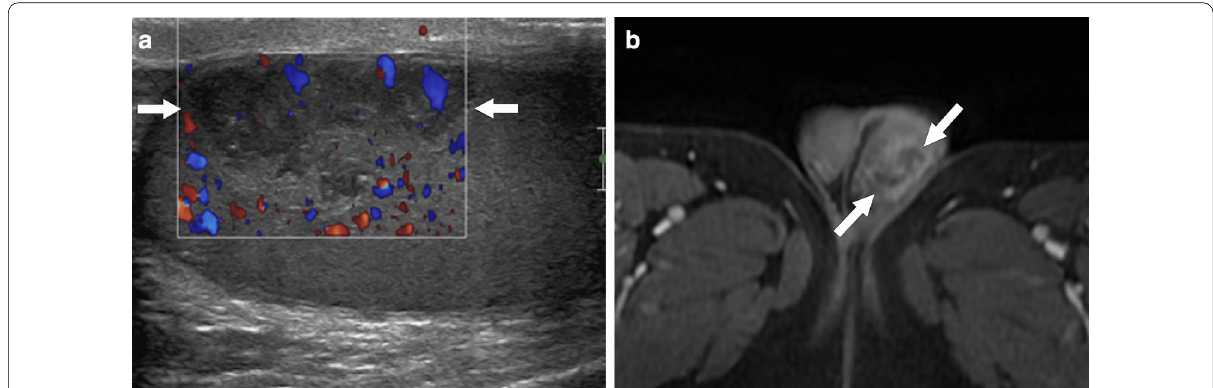
Fig. 8 Testicular abscess. A 30-year-old healthy male with testicular pain and palpable scrotal mass. Clinical history and physical exam, apart from palpable left testicular mass, were unremarkable. a Color Doppler ultrasound image demonstrates a complex cystic mass with increased peripheral and mild central vascularity (arrows). b Postcontrast fat suppressed T1W axial plane image shows predominantly peripherally enhancing left testicular mass (arrows). Polymicrobial abscess was pathologically confirmed after orchiectomy. No obvious underlying risk factor could